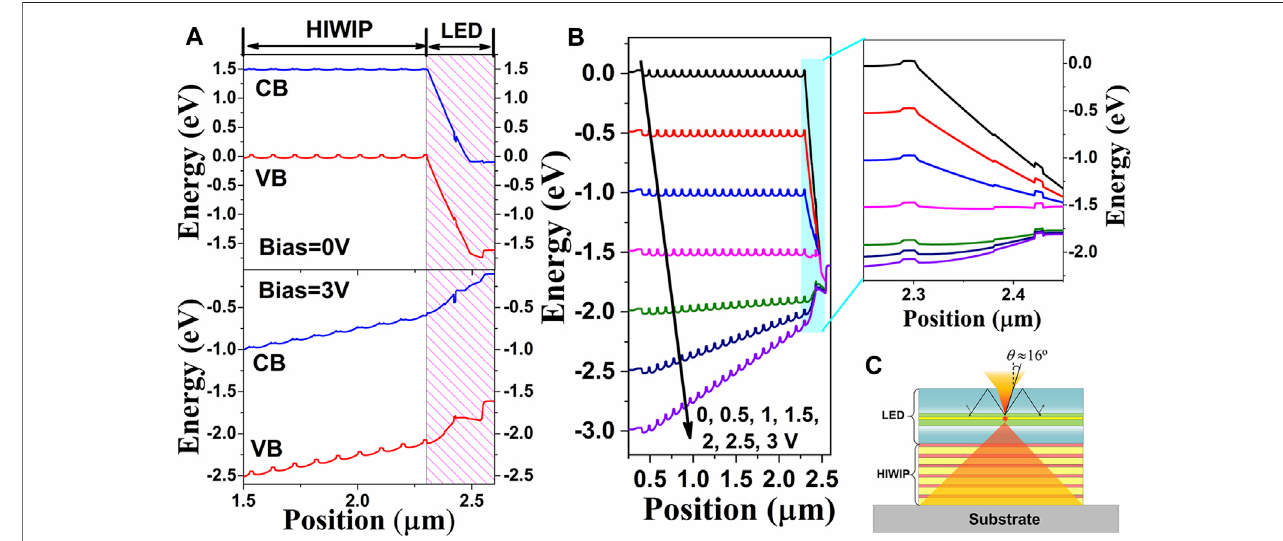
FIGURE 4 | (A) Calculated band diagram across the layer structure of the HIWIP-LED upconversion device under the bias of 0 and 3 V, with the top contact being grounded. (B) Calculatedresultsofthevalence banddiagramunderdifferentbiasvoltagewiththelargerversionoftheLEDbanddiagram. (C) Schematicdiagramofthe total internal re fl ection and critical angle at the air/semiconductor